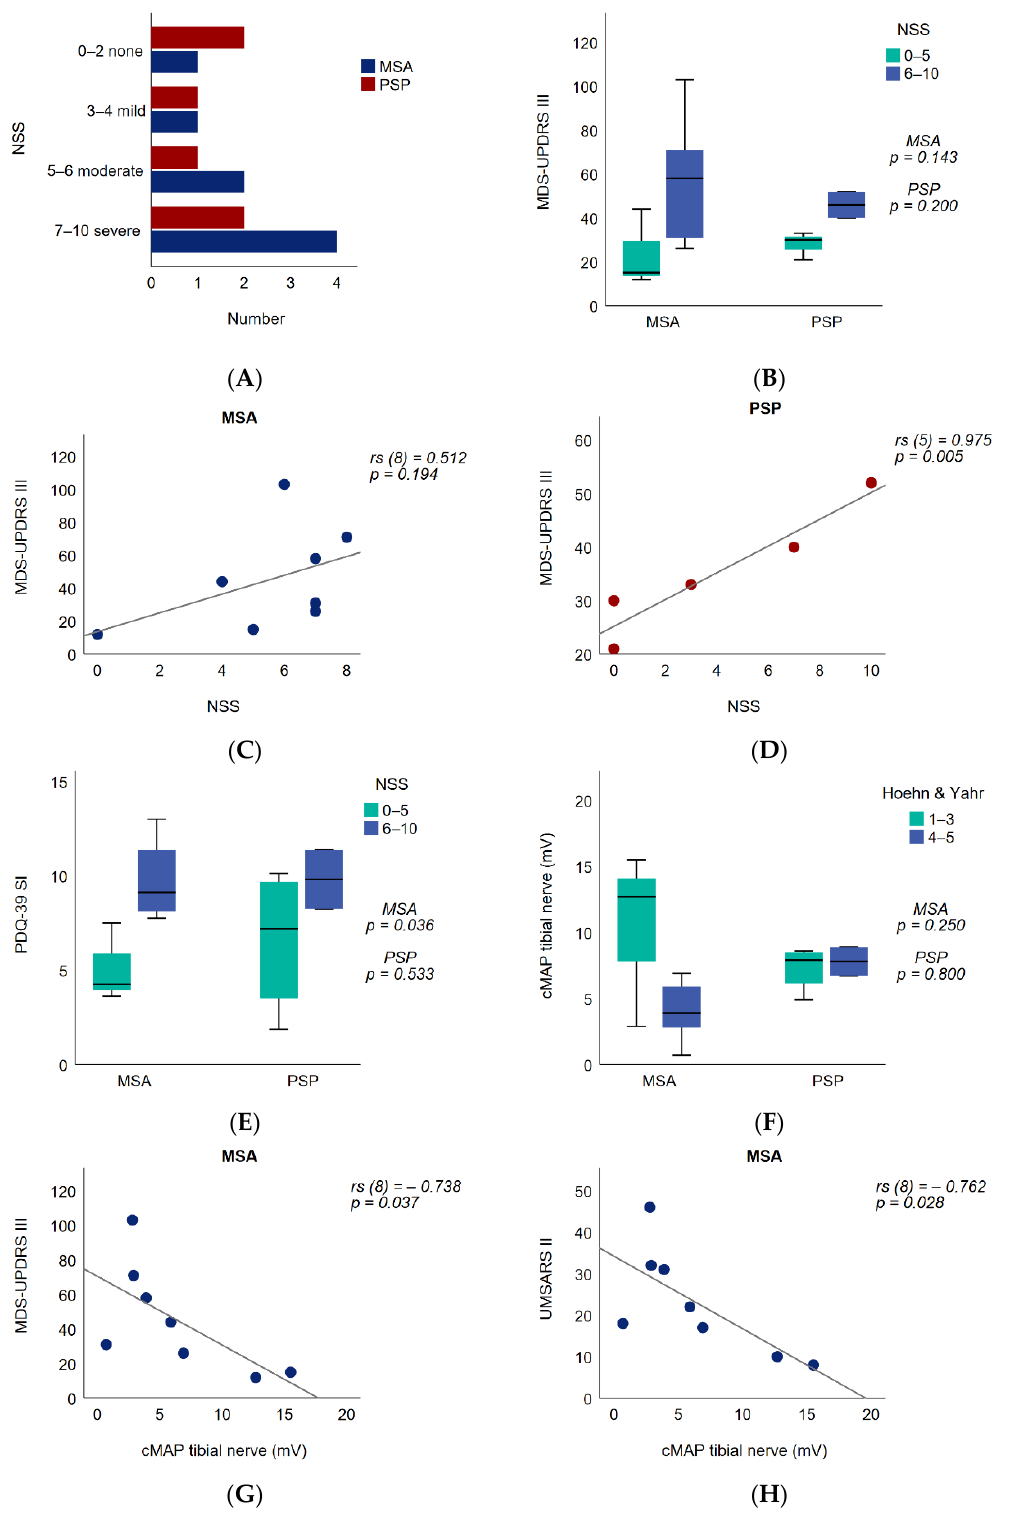
Figure 2. ( A ) NSS score. ( B ) MDS-UPDRS III in NSS groups. ( C ) MSA: MDS-UPDRS III in relation to NSS. ( D ) PSP: MDS-UPDRS III in relation to NSS. ( E ) PDQ-39 SI in NSS groups. ( F ) Amplitude of the tibial nerve in Hoehn and Yahr groups. ( G ) MSA: MDS-UPDRS III in relation to the amplitude of the tibial nerve. ( H ) MSA: UMSARS II in relation to the amplitude of the tibial nerve.